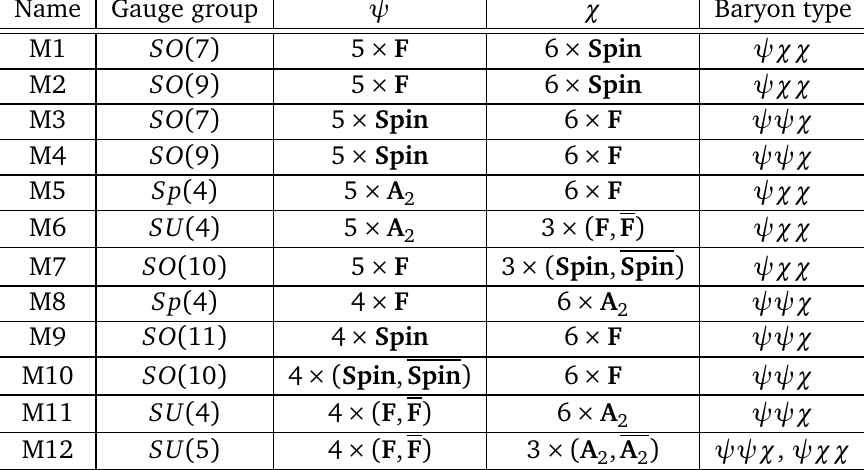
Table 1: The gauge and matter content of the models of interest for Partial Compos- iteness. The seemingly haphazard ordering is due to the fact that they were labeled following the cosets they give rise to (not shown here). Spin denotes the spinorial representation of SO ( N ) , A and F denote the two-index anti-symmetric and funda- 2 mental representations. The “baryon” type denotes schematically where the singlet is to be found (including also the possibility of using the charge conjugates). Note that, because of ε abcde , the last model admits baryons of both